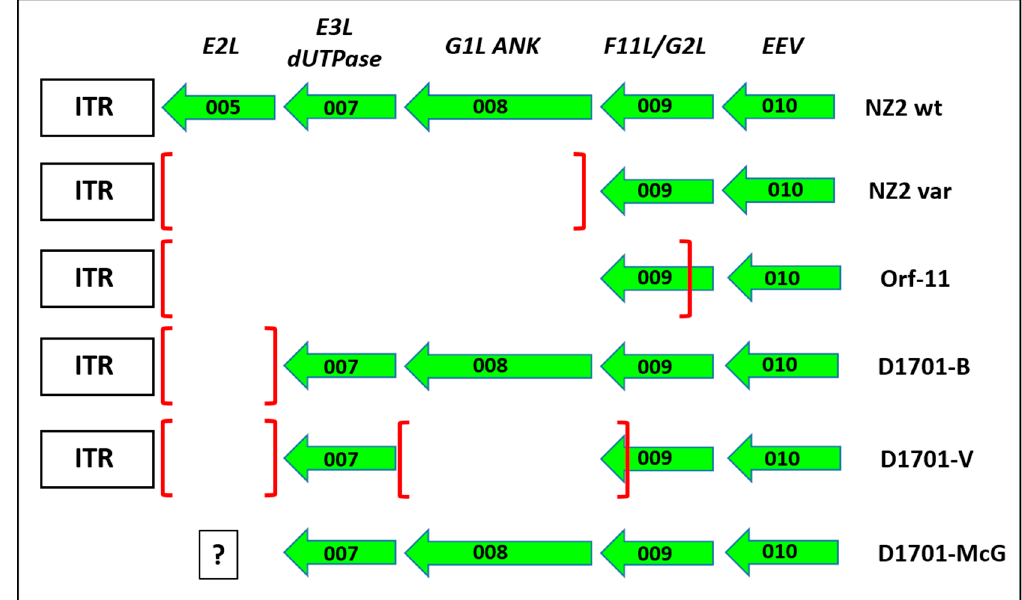
Figure 8. Comparison of gene deletions in the left hand end of ORFV genomes The gene deletions mapped in the left terminus of the genome of the different cell culture passaged ORFV variants NZ2var [72] and Orf ‐ 11 [73] are depicted in comparison to the prototype ORFV wild ‐ type (wt) strain NZ2 and to the D1701 derivatives as explained in the text. The earlier first designations for the ORFV genes are given in the upper line, EEV means that this ORF010 encodes an ORFV envelope protein. ITR denotes the inverted terminal region. The framed question mark given for D1701 virus sequenced by McGuire (D1701 ‐ McG) indicates the lack of sequence data left to the ORF007. The squared brackets mark the deleted part in each virus variant.